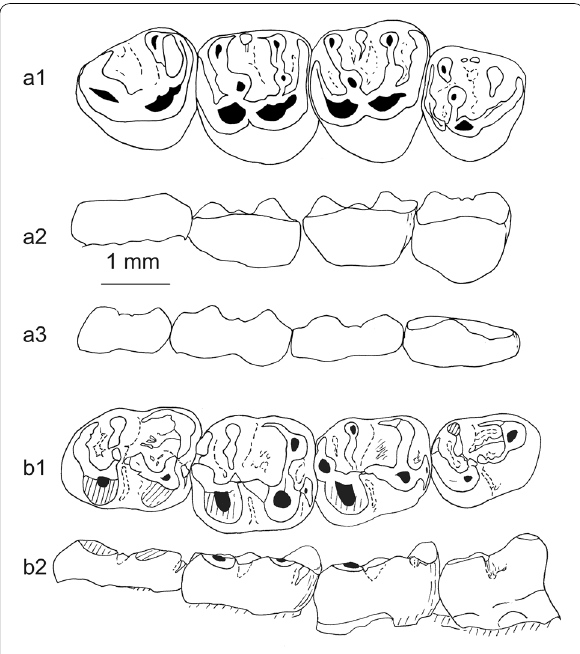
Fig. 4 Protadelomys cartieri (Stehlin & Schaub, 1951), from Egerkingen (Swiss Jura). a . Ef 1002, Holotype, right upper tooth row, P4–M1–3; a1, occlusal view, a2, lingual aspect; a3, buccal aspect. b . Eg 587, right lower tooth row, p4–m1‑3; b1, occlusal view; b2, buccal aspect. Scale bar: 1 mm